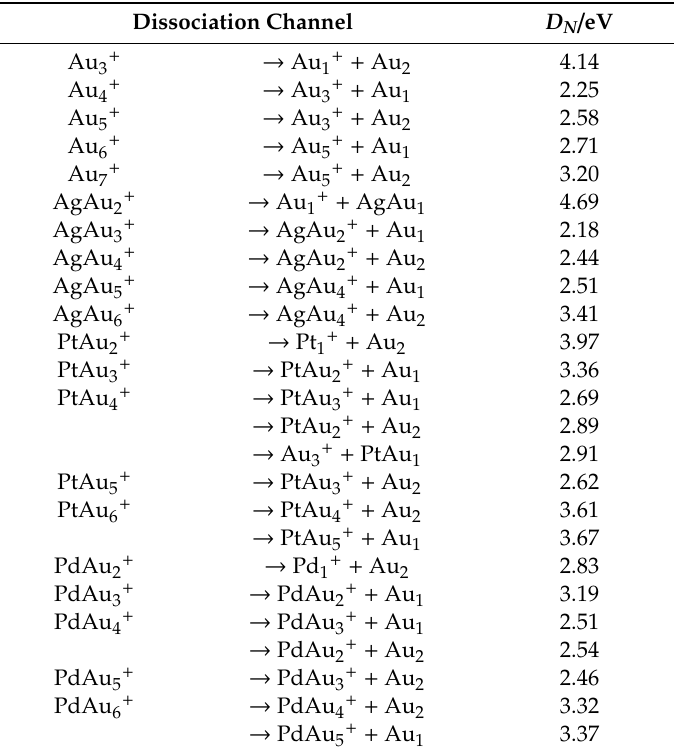
and M Au N − 1 + ( N = 3–7, M = Ag, Pt, Pd) calculated by density functional